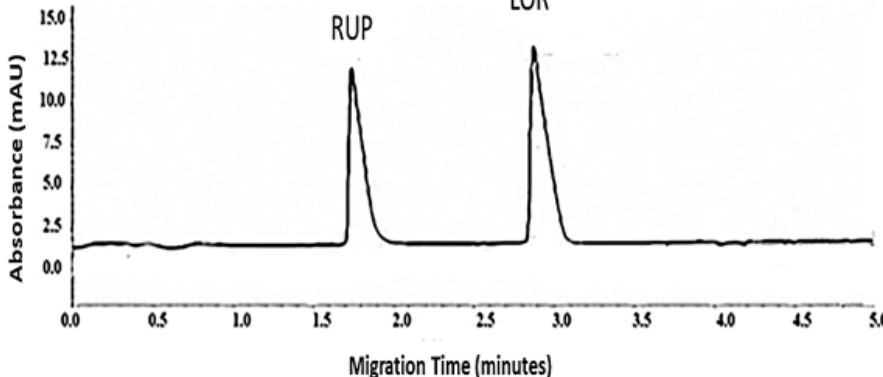
FIGURE 1 - Electropherograms of standard solutions. RUP – Rupatadine (400 µg/mL) migration time 1.8 min. LOR – Loratadine (200 µg/mL) migration time 2.8 min. Conditions: fused silica capillary 50.2 cm (40.0 cm effective length) x 75 μm i.d.; electrolyte: boric acid 35 mmol/L, pH 2.5, adjusted with orthophosphoric acid, applied voltage of 20 kV, hydrodynamic injection of 3447.32 Pa for 3 seconds, temperature of 25 ºC. UV detection at 205